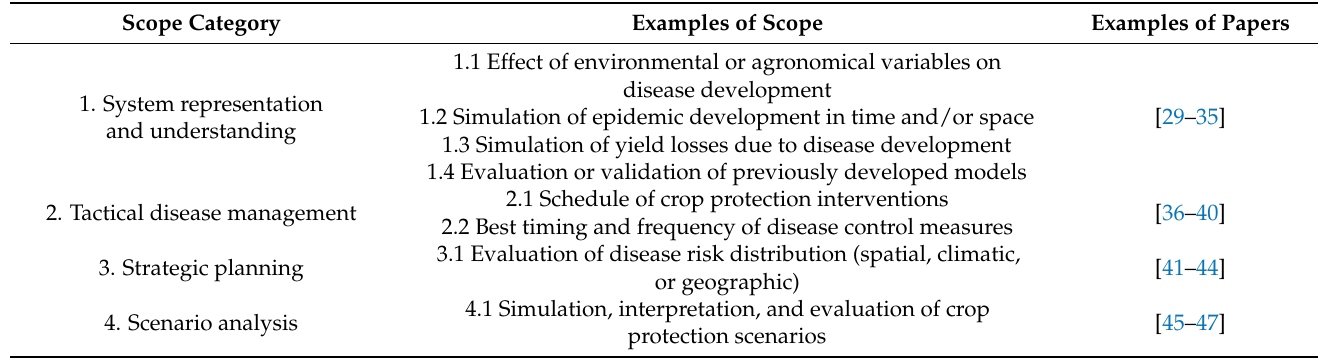
Table 3. Assignment of models according to scope and purpose, and references of some examples of works for each